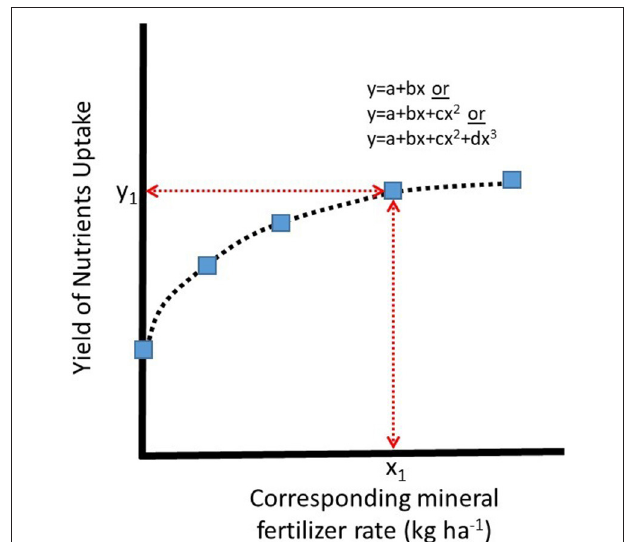
FIGURE 4 | Illustration of a FEV idealized response curve, where “a” is the intercept (crop yield or nutrients uptake at 0kg ha − 1 of mineral fertilizer); “b, c, and d” are the linear, quadratic, and cubic coefficients,